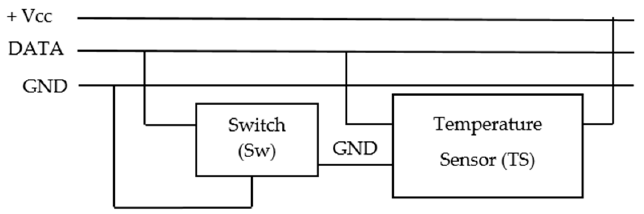
Figure 6. 1-Wire bus connection of the temperature sensor + switch set.